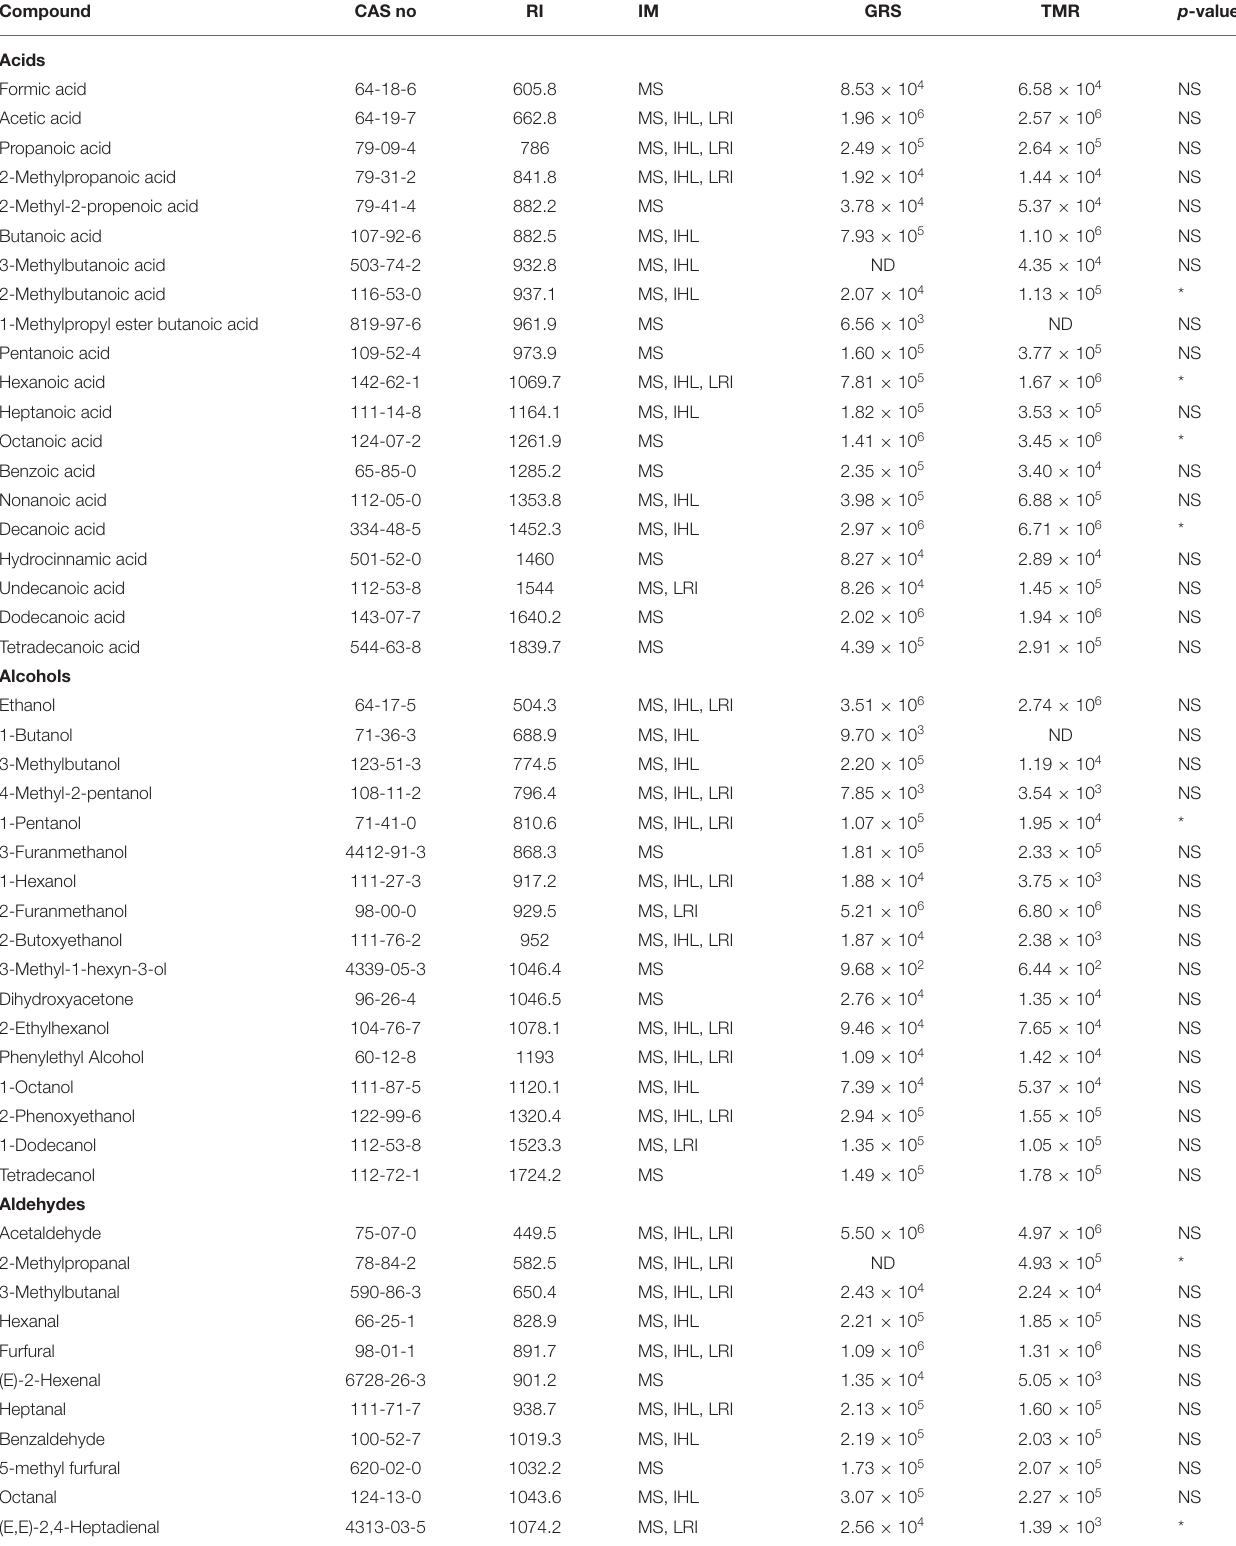
TABLE 1 | Volatile compounds identified in raw bovine milk from cows-fed grass (GRS) or total mixed ration (TMR) by HiSorb-GC-MS.